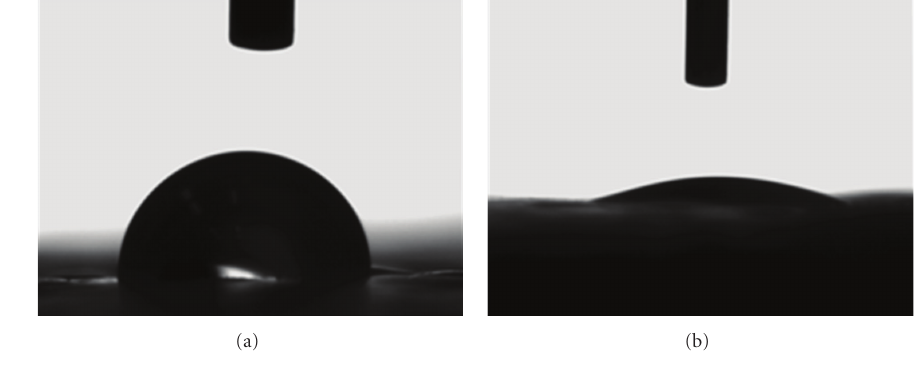
Figure 2: Contact angle: (a) Orosei; (b) Orosei Active tiles.